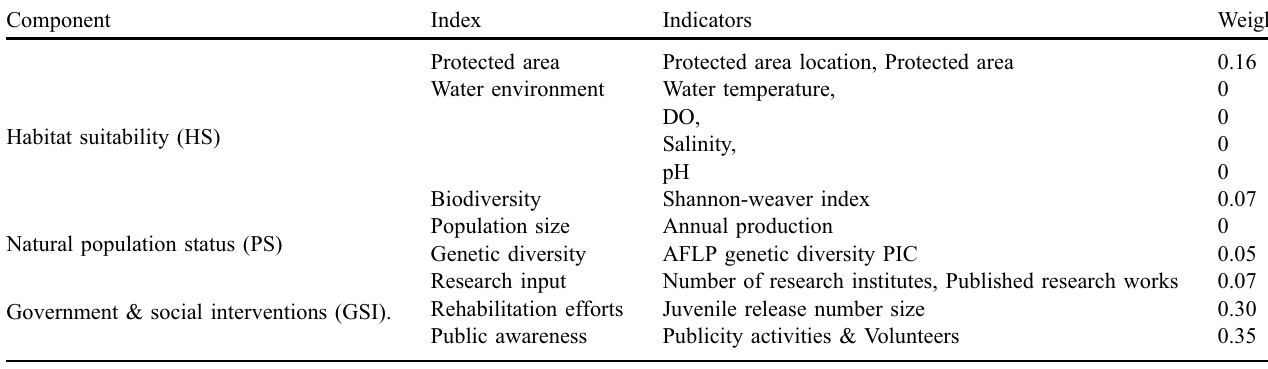
Government & social interventions